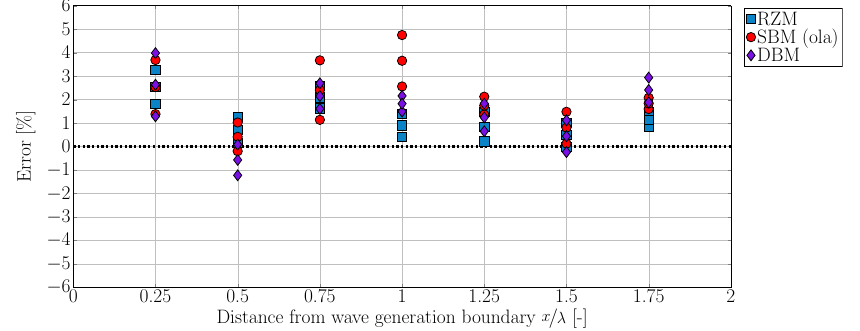
σ ¯ (cid:101) for the shallow water mSS at different locations along the CNWT. Figure 22. ¯ (cid:101) ¯ H ± ¯ H σ ¯ (cid:101) In Figure 22, a maximum error ¯ (cid:101) ¯ of 5% can be observed, indicating an increase compared H ± ¯ H